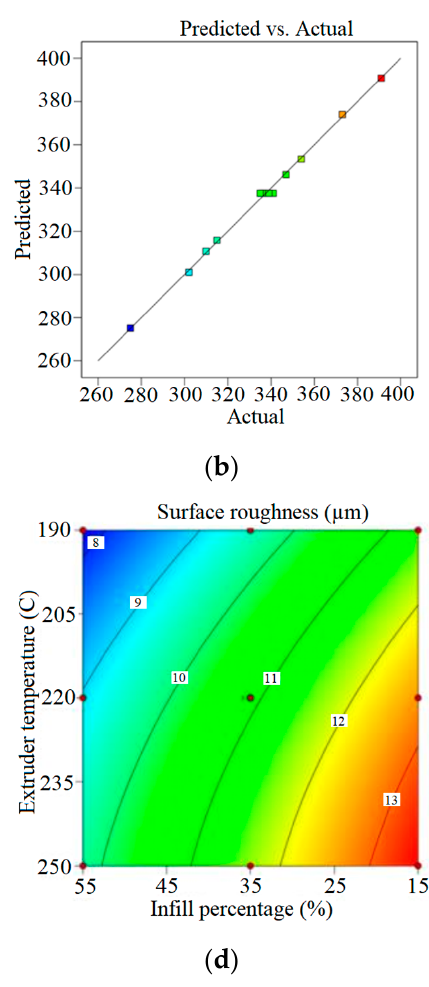
Table 5. Analysis of variance (ANOVA) for FL.